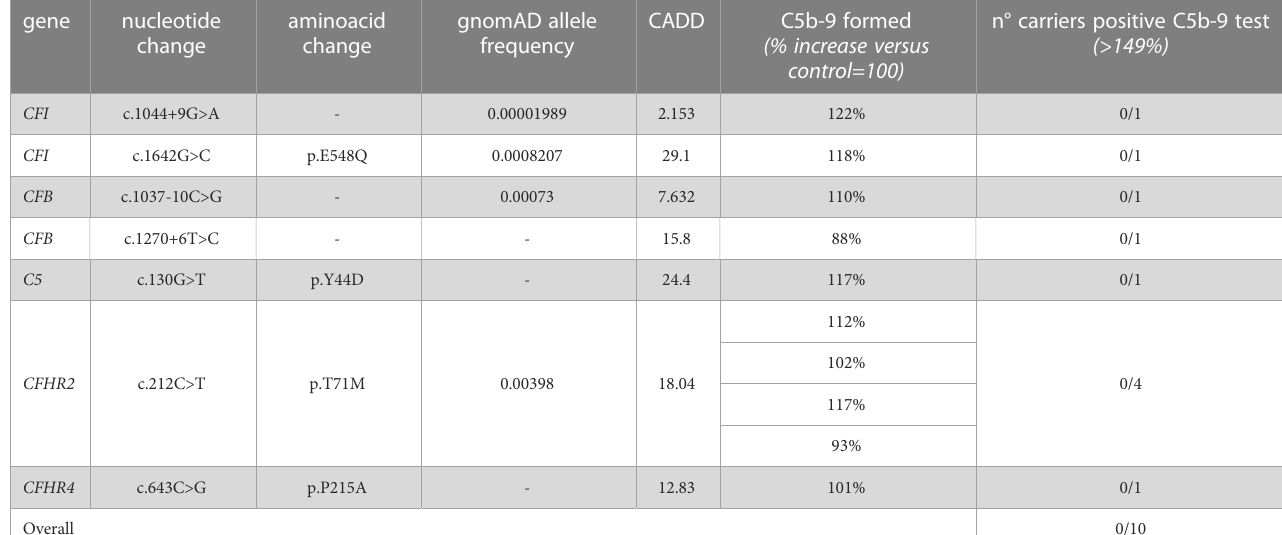
TABLE 6 Results of C5b-9 formation test in family members who carry variants not segregating with the disease.